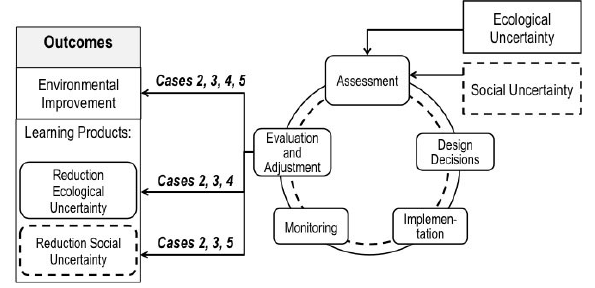
Fig. 4 . Outcomes of adaptive management